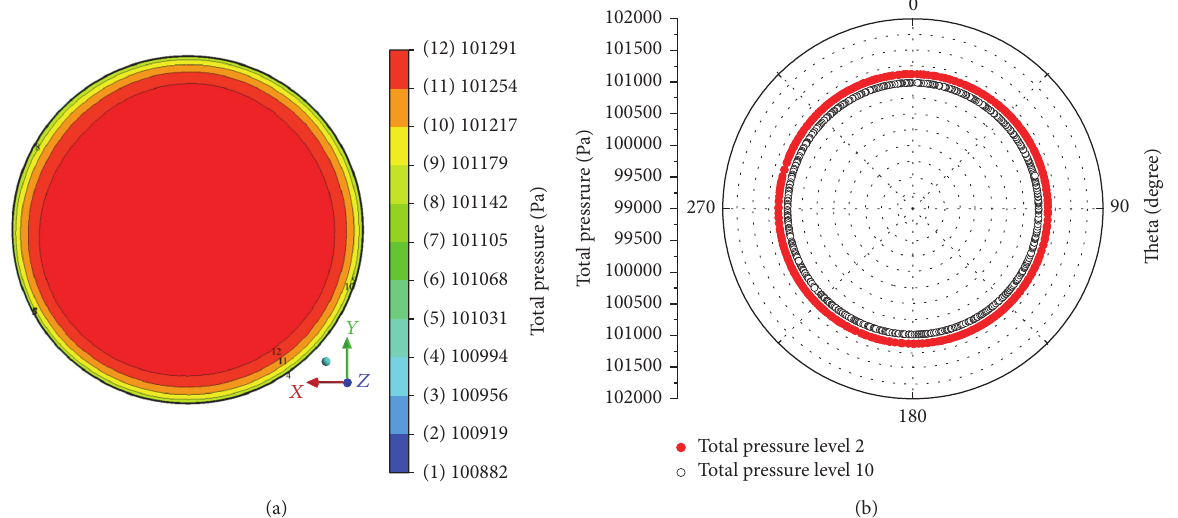
Figure 8: Distributions of the total pressure (a) and total pressure level 2 and level 10 (b) in the theta direction at 1.0 𝑄 𝑑 .